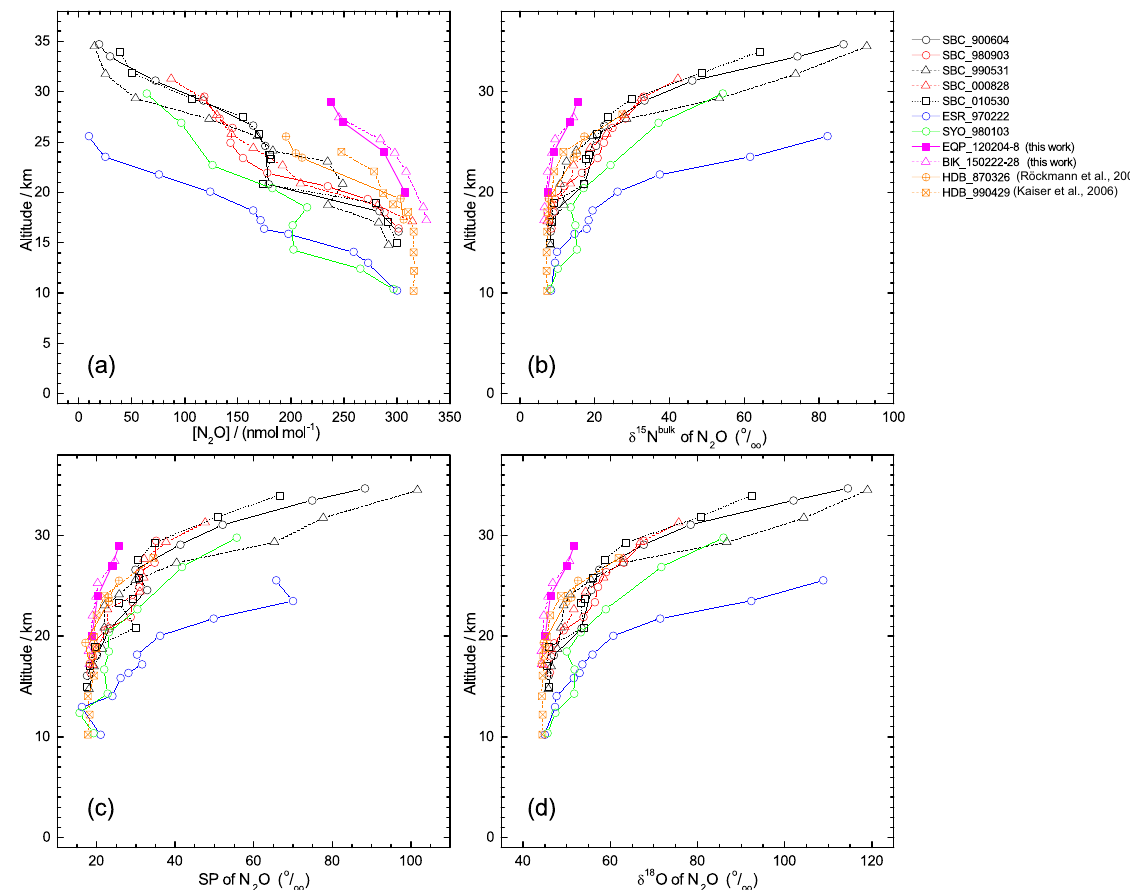
Figure 2. Vertical profiles of mixing ratio (a) , δ 15 N bulk (b) , SP (c) , and δ 18 O (d) , of N 2 O observed over the Equator (pink symbols). Previously published results obtained over Japan (black and red symbols), Sweden (blue), and Antarctica (green) (Toyoda et al., 2001, 2004), and India (orange; Kaiser et al., 2016; Röckmann et al., 2001) are also shown. In the legend, launch sites and dates are shown, respectively, by three characters and six digits in yymmdd format. SBC, Sanriku Balloon Center, Japan; ESR, Esrange, Kiruna, Sweden; SYO, Syowa station, Antarctica; HDB, Hyderabad, India; EQP, eastern equatorial Pacific; BIK, Biak Island, Indonesia. See also Table S2 for